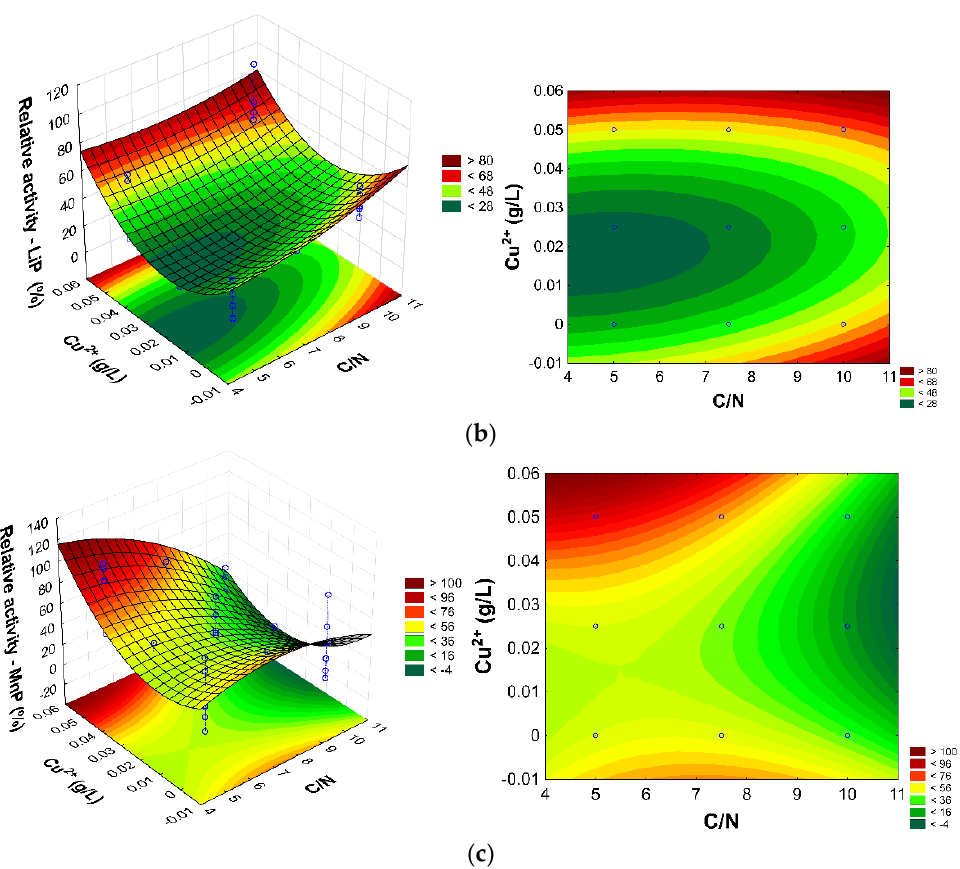
Figure 2. Response surface and contour plot (( a ): LAC; ( b ): LiP; ( c ): MnP) for relative activity as a function of the C/N ratio and concentration of Cu 2+ , fixing Mn 2+ = 1.5 mM, VA = 3 mM and T80 = 0.025% v / v .